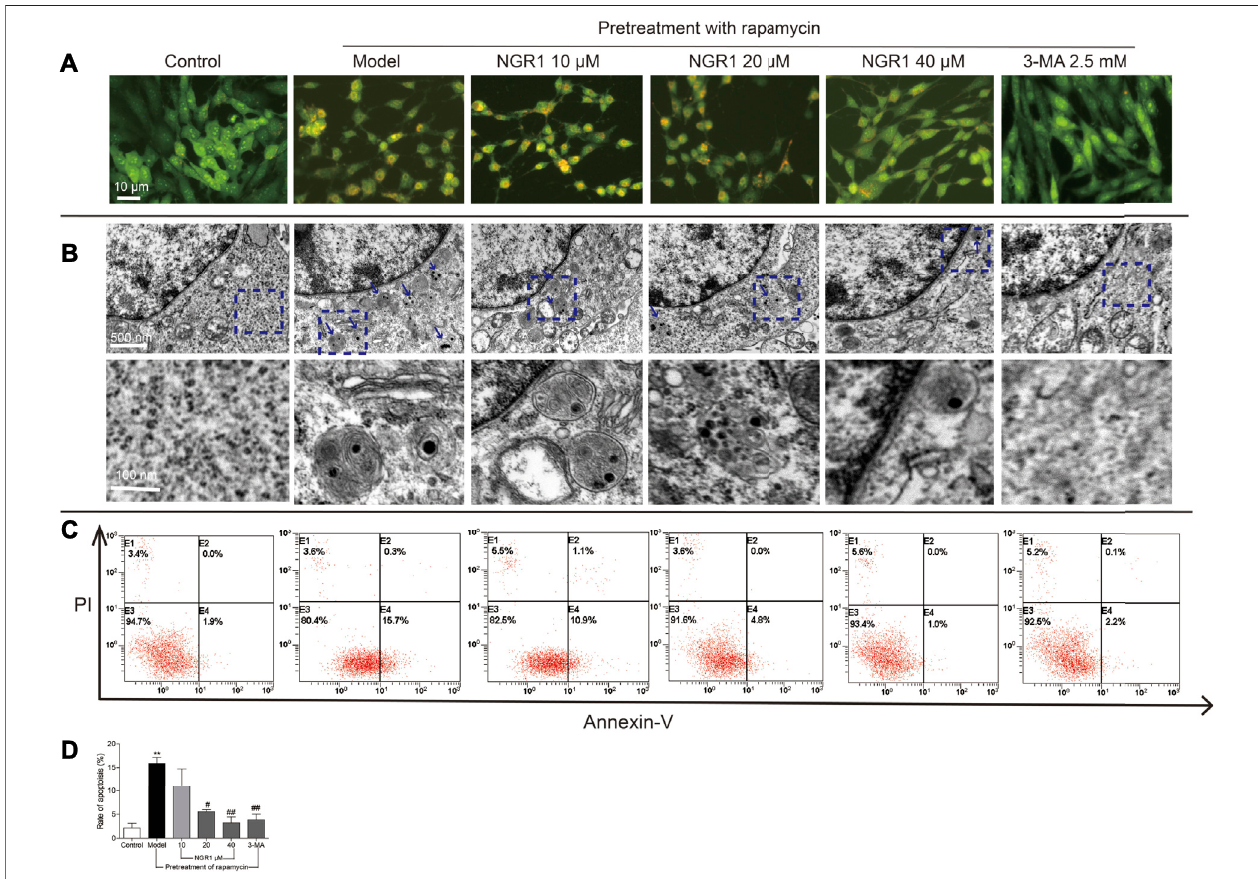
FIGURE 4 | NGR1 reduced autophagy and apoptosis of HT-22 cells induced by rapamycin. (A) Acidic vesicular organelles stained by acridine orange. Scale bar: 10 µm (B) Autophagosomes in cells examined by transmission electron microscopy. The autophagosomes were denoted by arrows. Scale bar: 500 and 100 nm. (C) and (D) Apoptosis examined by fl ow cytometry after annexin V/PI staining. n (cid:1) 3/group. ** p < 0.01 vs. control group. # p < 0.05, ## p < 0.01 vs. model group. (NGR1: notoginsenoside R1; 3-MA, 3-methyladenine).